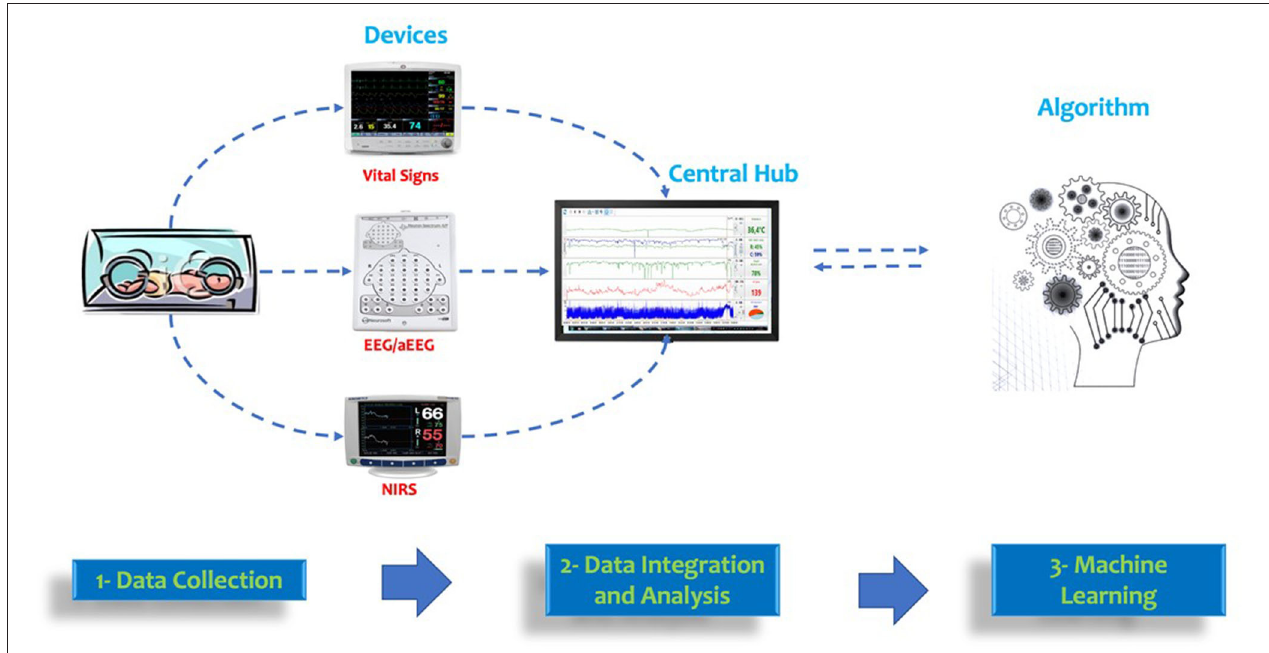
FIGURE 3 | Overview of data collection and integration for multimodal monitoring in the NICU. Data from vital signs, EEG/aEEG, and NIRS devices can be integrated into a central hub. This data can be used for machine learning algorithms using continuous monitoring